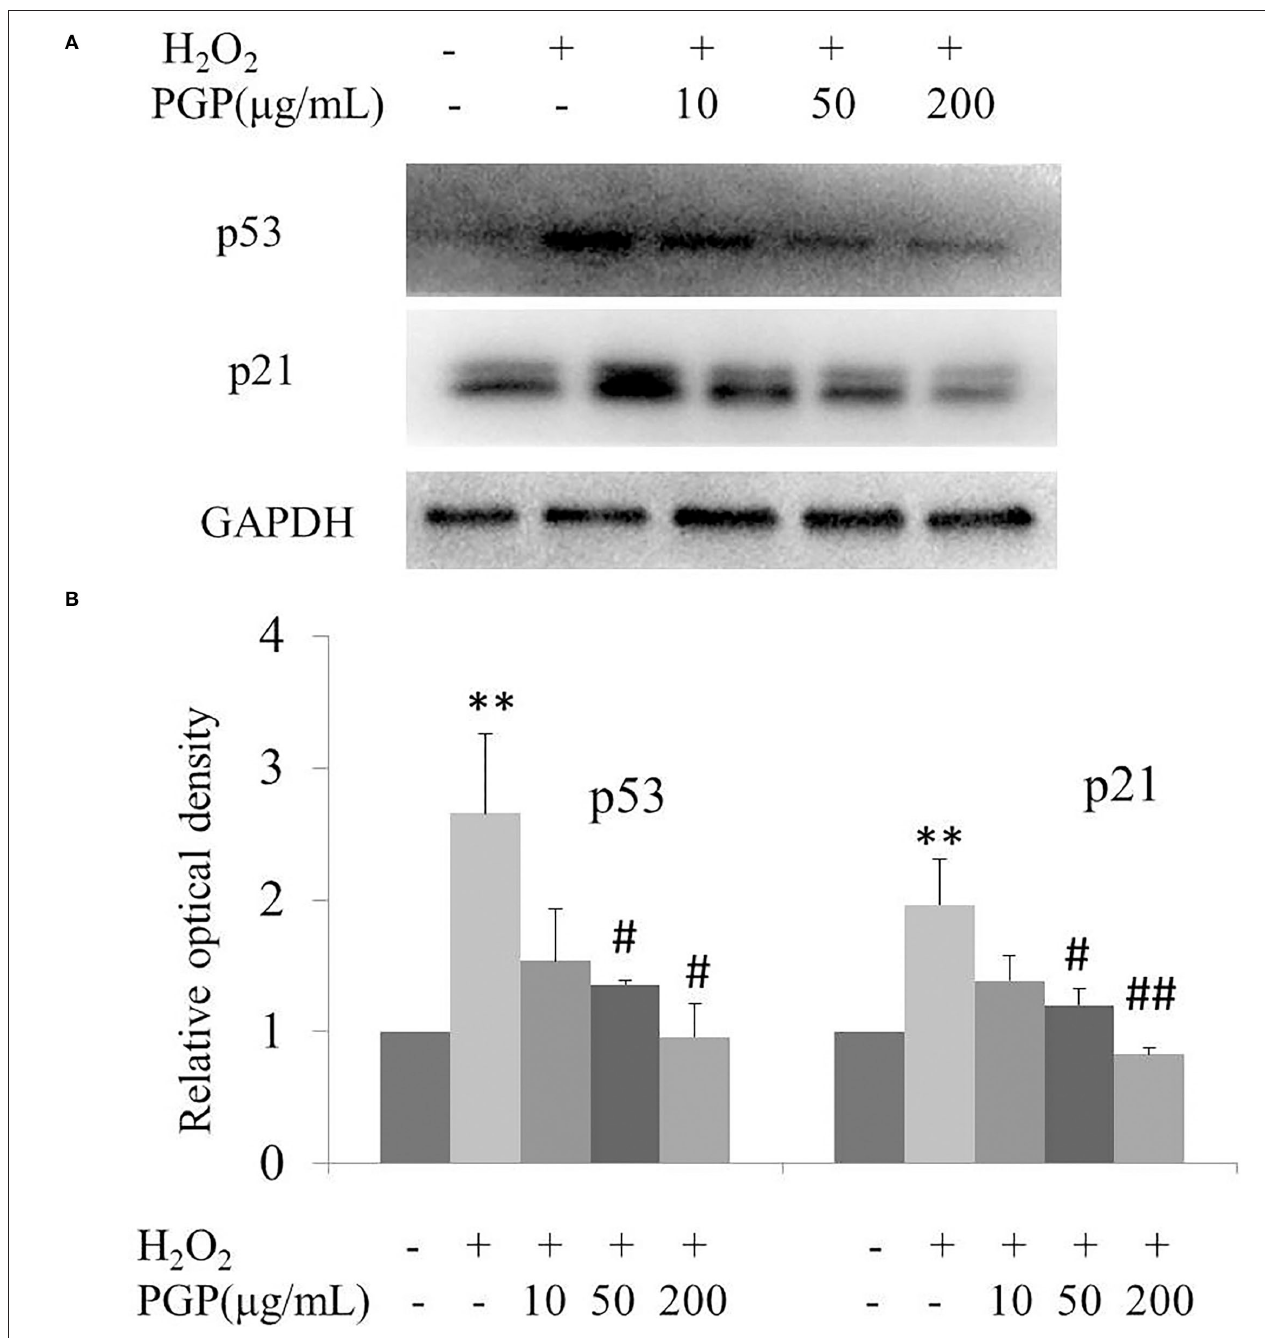
FIGURE 7 | The expression of senescence-associated proteins (A) and relative optical density of P53 and P21 in H 2 O 2 -treated young 2BS cells incubated with various concentrations of PGP (** p < 0.01 vs. control group; # p < 0.05 vs. H 2 O 2 alone group; ## p < 0.01 vs. H 2 O 2 alone group). Bars represent relative protein levels counted as D 1 /D 0 (the value for control was set as 1.0), where D 0 and D 1 stand for the optical density of GAPDH ladder and sample ladder, respectively. The optical density for each ladder was calculated using the ImageJ software. Data were obtained from three independent